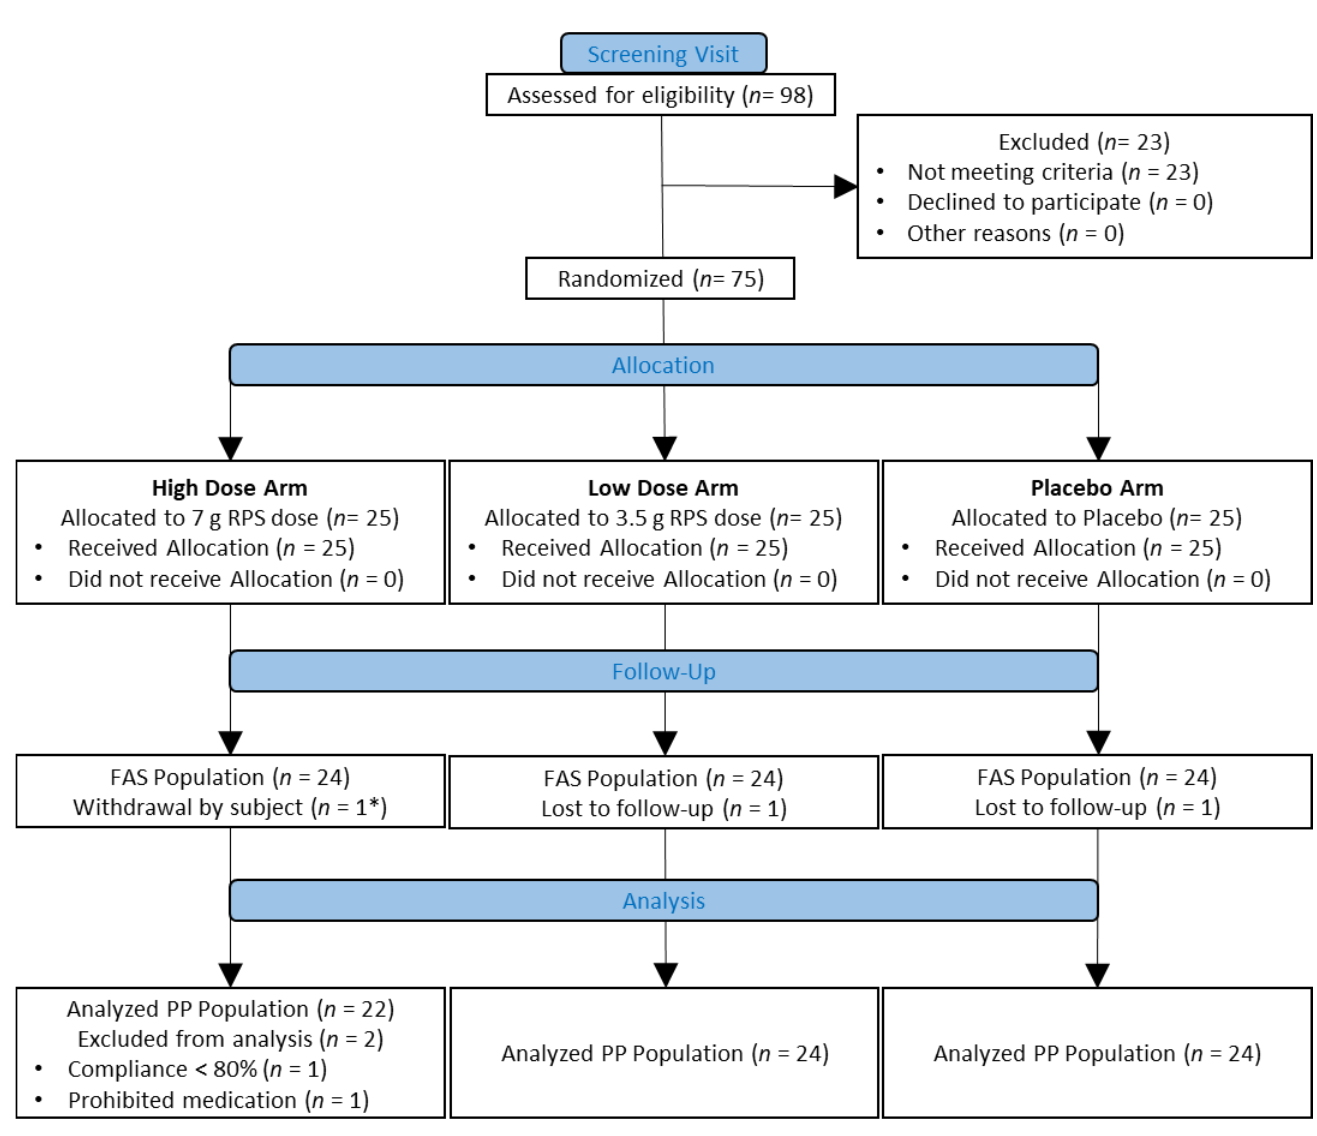
Figure 1. CONSORT flow diagram. Ninety-eight people were assessed for eligibility, of which 75 were randomized to one of three treatment arms: High dose (7 g Resistant potato starch (RPS) per day), low dose (3.5 g RPS per day), or placebo (Corn starch). Full analysis set (FAS) and per protocol (PP) populations are indicated, including reasons for participant attrition.